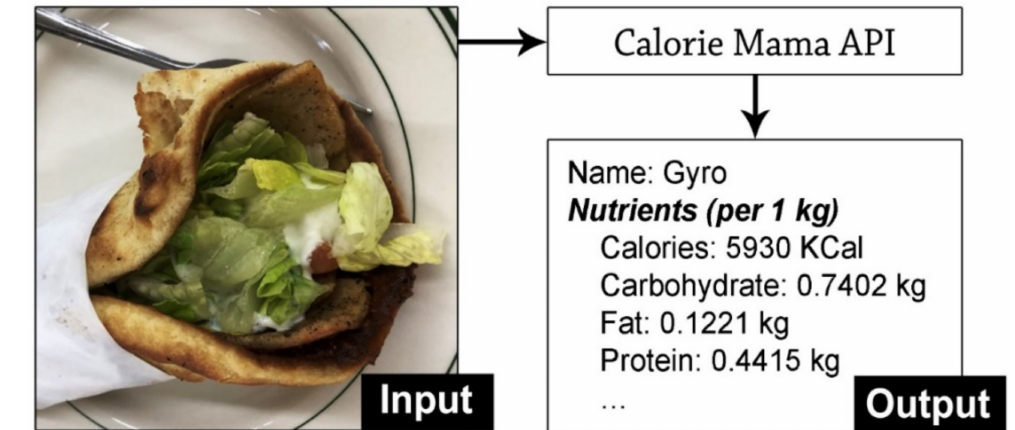
Figure 2. Example of nutrition assessment by the deep learning model.